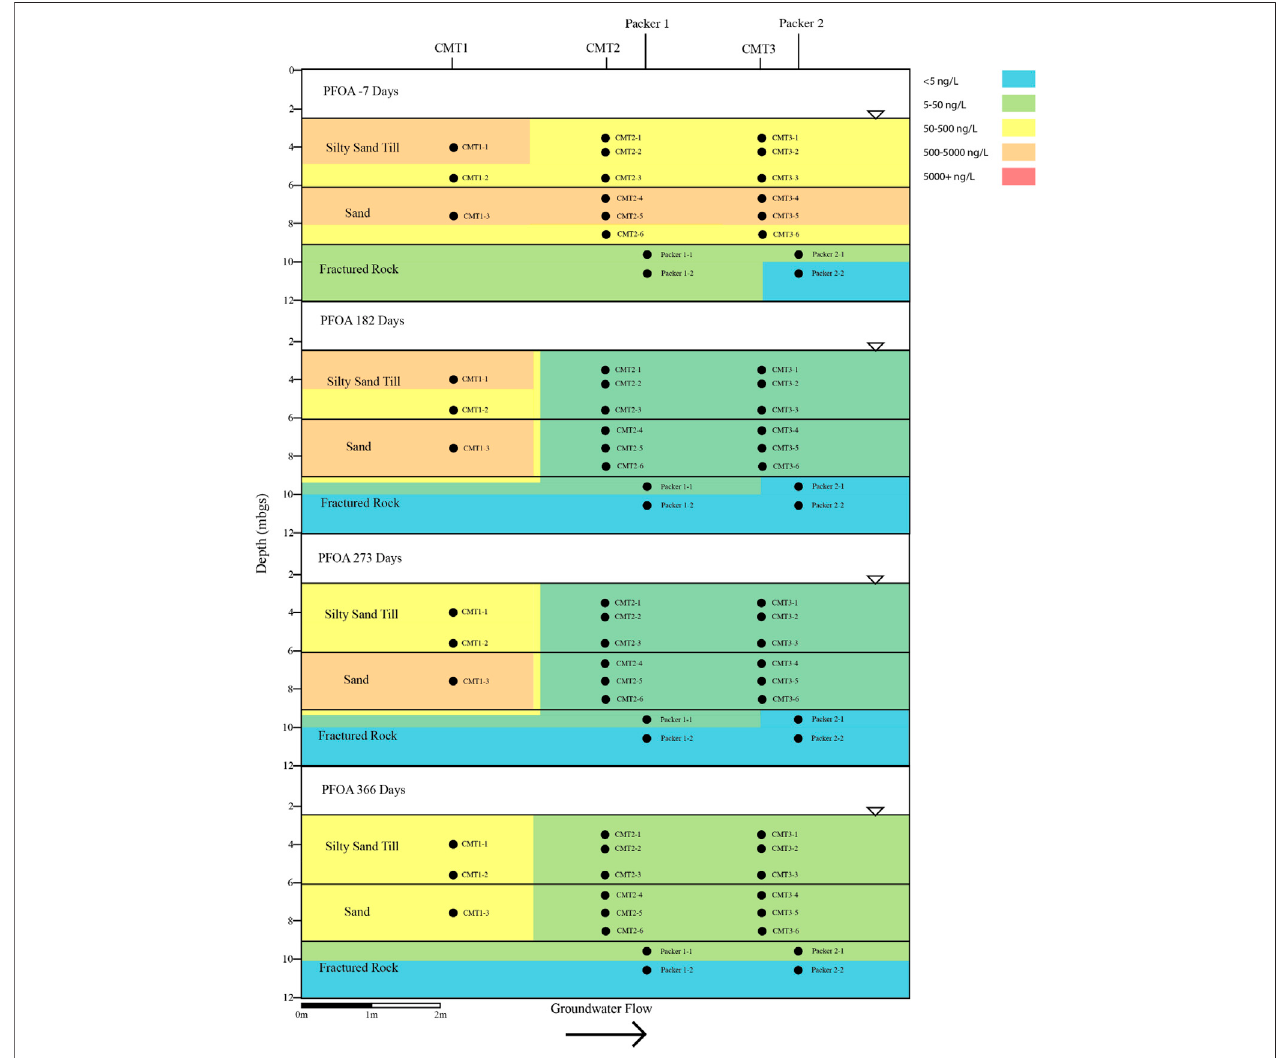
FIGURE 6 | Cross sectional view of PFOA within groundwater determined pre and post-injection of the CAC within the three aquifers.